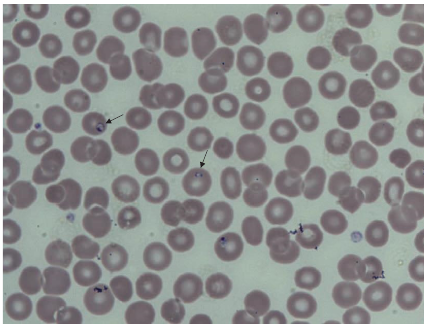
Figure 1: Peripheral blood smear. Te arrows indicate intra- erythrocytic ring forms (Wright-Giemsa stain). 1000x magnifca- tion was used for microscopic